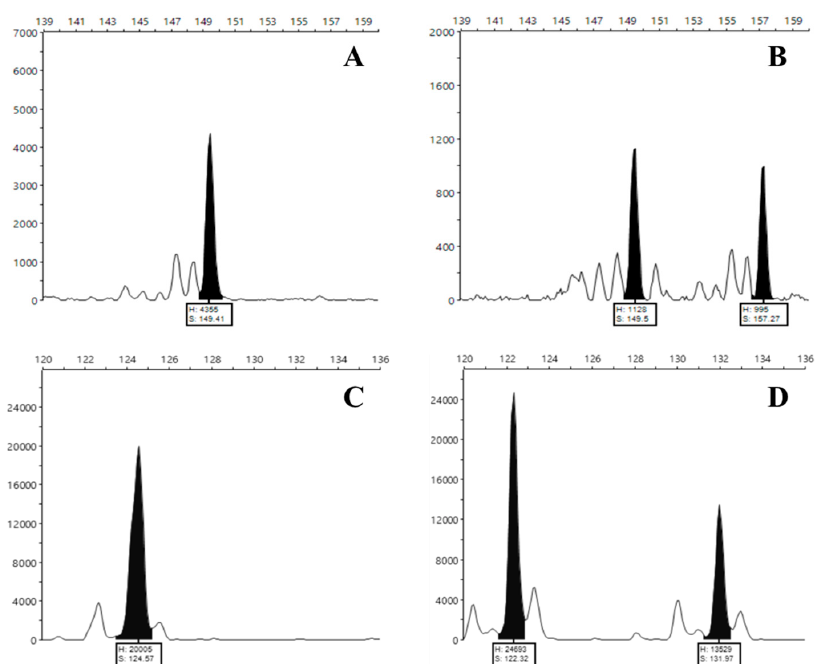
Figure 2. Capillary polyacrylamide gel electropherograms: ( A , B ) locus MT327557, ( A )